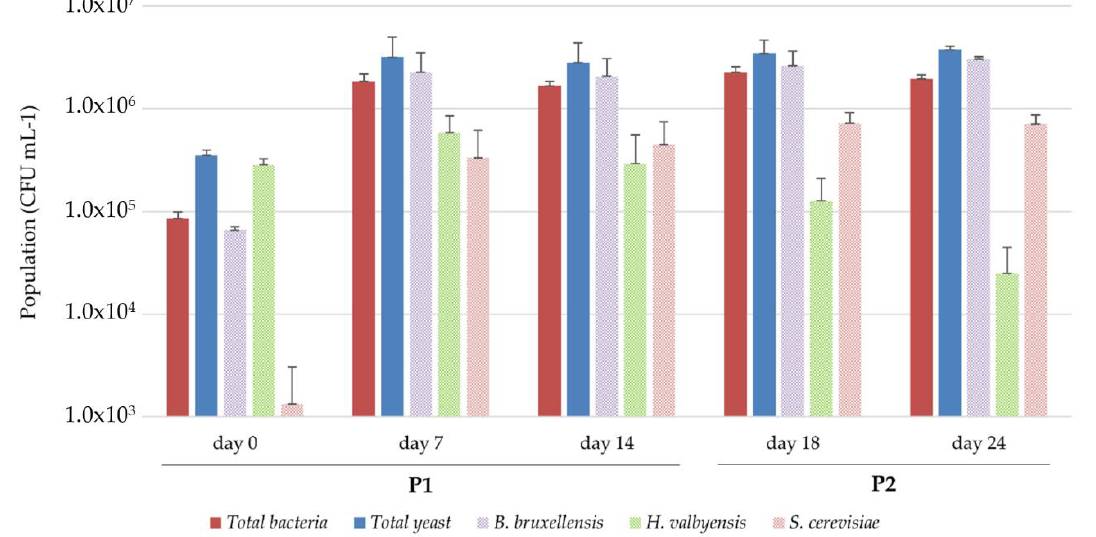
Figure 3. Microbial populations during cultivation in sugared black tea of the black tea kombucha consortium determined by plate counting (CFU mL − 1 ). Error bars correspond to the confidence interval with α = 0.05 ( n = 3).